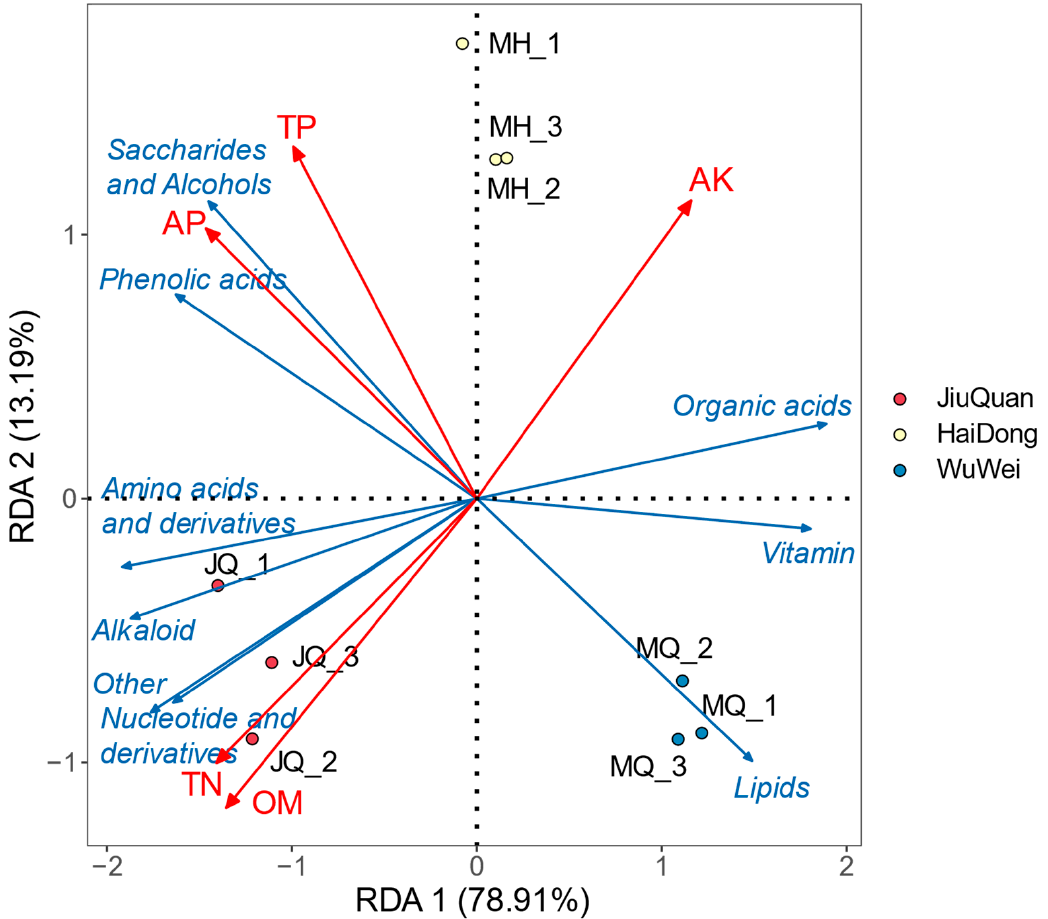
Figure 8. RDA plots of metabolites related to soil physicochemical properties. Yellow: HaiDong (MH1 ‐ 3); red: JiuQuan (JQ1 ‐ 3); blue: WuWei (MQ1 ‐ 3). The angle between soil physicochemical properties and metabolites indicates the correlation magnitude. The smaller the angle, the higher the correlation and vice versa.